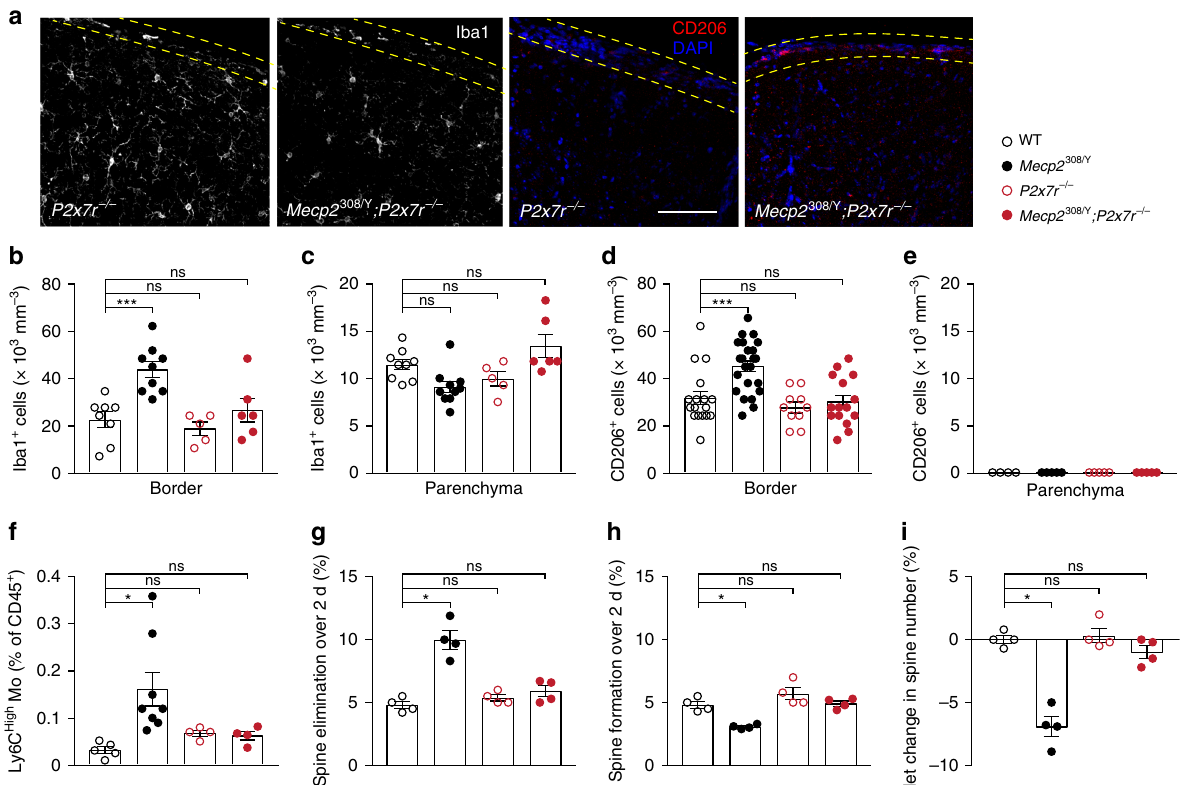
Fig. 3 P2X7R knockout reduces cortical in fl ammation and dendritic spine loss in Mecp2 308/Y mice. a Representative coronal sections of the mouse cortex stained for Iba1 and CD206 in P2x7r − / − and Mecp2 308/Y ; P2x7r − / − mice (4 – 6 months old). Scale bar, 80 µ m. b , c Quanti fi cation of Iba1 + cell density in the cortical border ( n = 8, 9, 5, 6; P = 0.0007, 0.9407, 0.9135 vs. WT) and parenchyma ( n = 9, 10, 5, 6; P = 0.0732, 0.5915, 0.2845 vs. WT). Black empty circle, WT; black fi lled circle, Mecp2 308/Y ; red empty circle, P2x7r − / − ; red fi lled circle, Mecp2 308/Y ; P2x7r − / − . d , e Quanti fi cation of CD206 + cell density in the cortical border ( n = 17, 23, 10, 15; P = 0.0009, 0.8110, 0.9902 vs. WT) and parenchyma ( n = 4, 5, 5, 5). f Relative percentages of monocytes in the cortex of WT, Mecp 308/Y , P2x7r − / − , and Mecp 308/Y ; P2x7r − / − mice ( n = 5, 8, 4, 4; P = 0.0137, 0.9034, 0.9418). Monocytes were